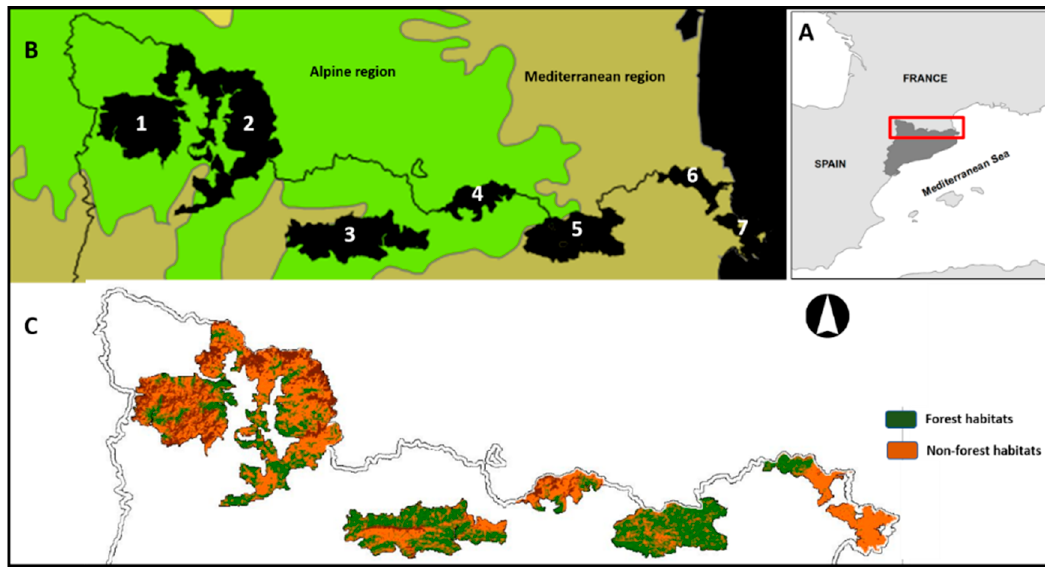
Figure 4. Map ( A ) Catalan Pyrenees. Map ( B ) The protected natural areas included in the analysis, ordered from west to east, were as follows: (1) Aiguestortes National Park (IUCN category: II); (6) Albera Natural Site of National Interest (IUCN Category III); (2) Alt Pirineu Natural Park, (3) Cadi-Moixero and (7) Cap de Creus Natural Park (IUCN category: V) and (4) Capcaleres del Ter i Freser Protected Area and (5) Alta Garrotxa Protected Area (IUCN category: VI). Map ( C ) Landscape patterns between forest and non-forest habitats.